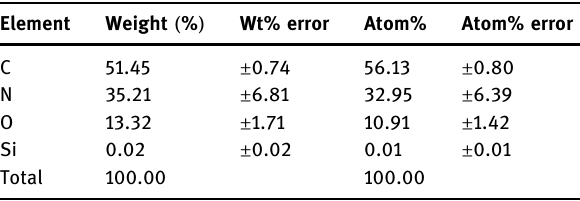
Table 5: Elemental properties of PEI - impregnated GRHC/ACNFs